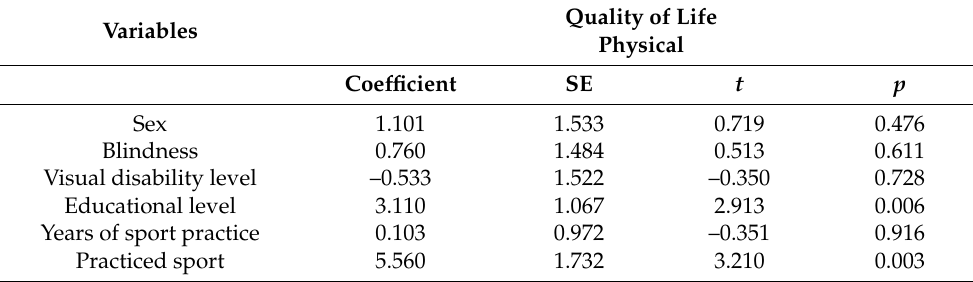
Table 4. Multiple linear regression analysis of characteristics of visually impaired athletes to predict physical quality of life.